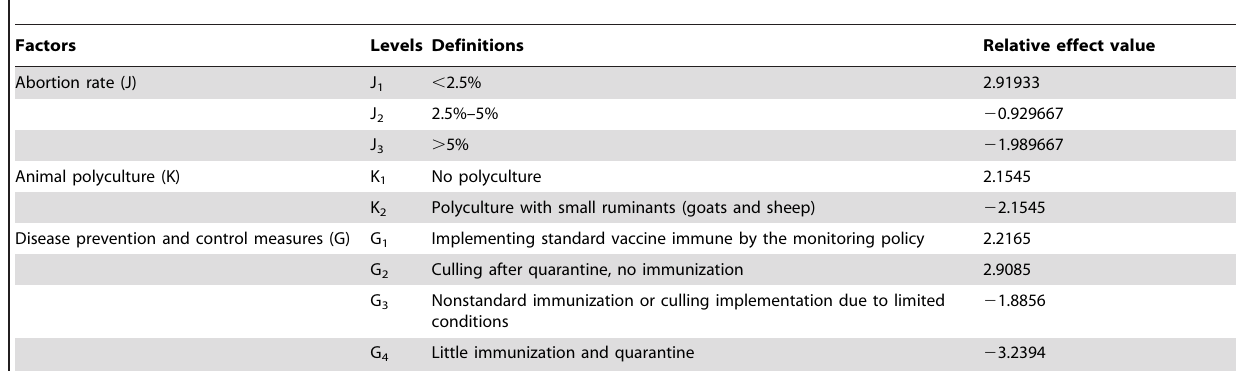
Table 6. Effect decomposition of risk factors to reducing Brucella contamination for raw